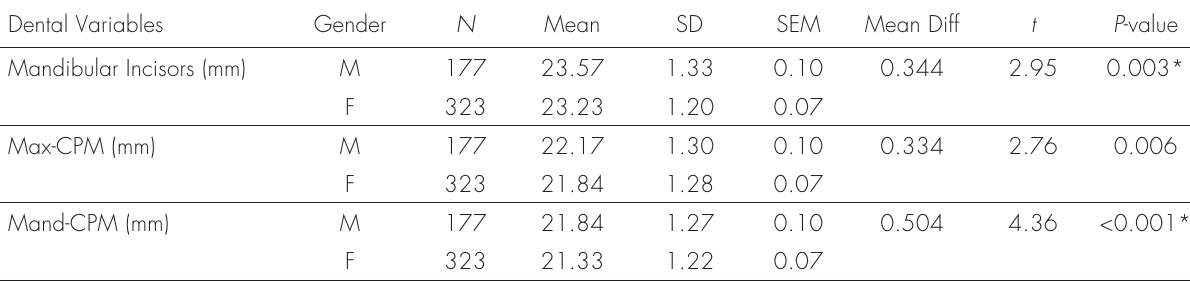
Table I. Comparison of mean study parameters of group of teeth in each gender using independent sample t test. Dental